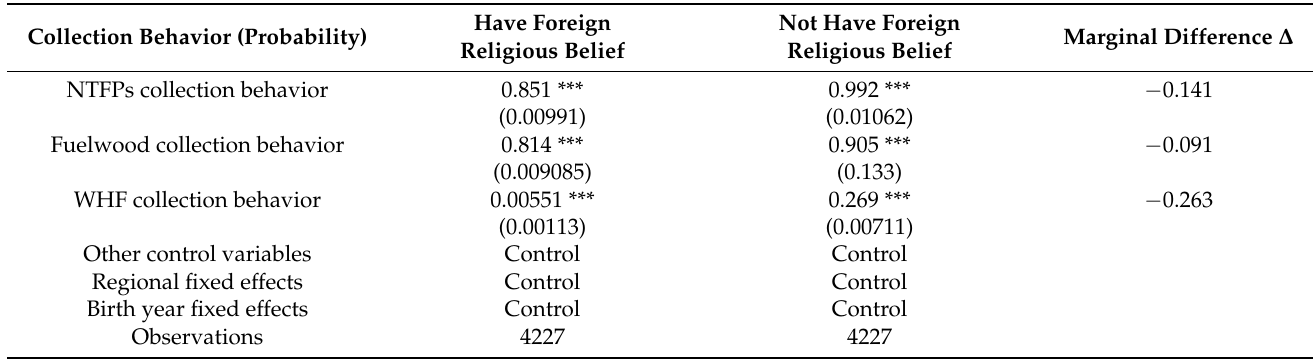
Table 13. The discrete marginal effect of foreign religious belief on collection